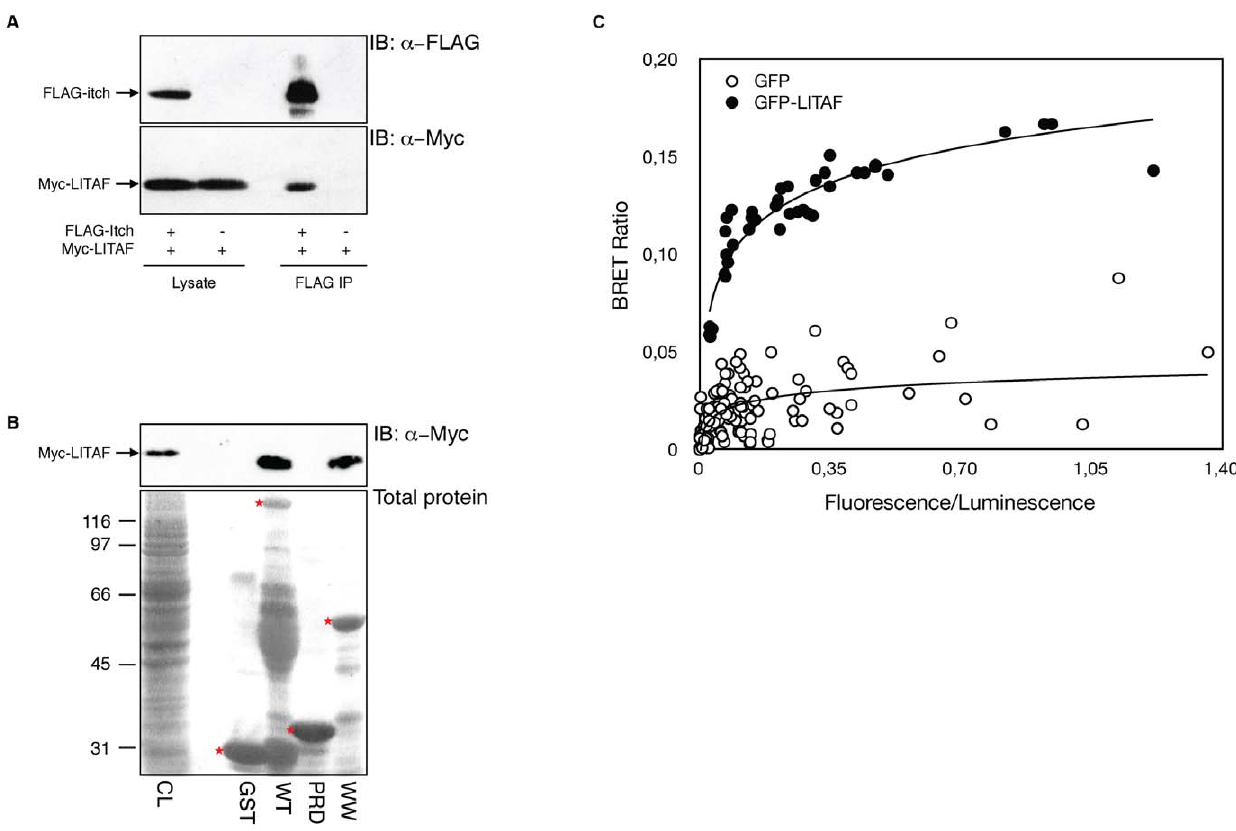
Figure 1. LITAF interacts with Itch invitro and invivo . (A) HEK-293T cells were transiently transfected with FLAG-Itch with or without co- transfection of myc-LITAF. Total cell lysates were blotted with anti-FLAG and anti-myc to show protein expression (lower panel), and immunoprecipitated with anti-FLAG to reveal LITAF co-immunoprecipitation (upper panel). (B) Extracts from 293T cells transfected with myc-LITAF were incubated with either GST alone, GST-Itch WT, GST-Itch PRD or GST-Itch WW pre-coupled to glutathione-Sepharose. Input proteins is shown in the first lane (CL). Proteins bound to GST beads are shown in the next lanes. Immunoblotting with anti- myc antibodies shows the presence of myc- LITAF (upper panel). Total gel loading is shown by ponceau staining of the blot to reveal GST loading. The bands representing the GST-fusions in the Ponceau staining are marked by a red asterisk. Additional staining in the GST-Itch-WT lane likely represents degradation products of the fusion protein. (C) 293T cells were co-transfected with constant amount of rLuc-Itch and various amounts of either GFP alone or GFP-LITAF. The graph is a representative example of the saturation studies performed to provide evidence for a specific interaction between the proteins. BRET ratios were plotted as a function of the excited GFP activity to total rLuc activity ratio, allowing comparison of BRET ratios between the negative control GFP and GFP-LITAF when expressed at the same level.